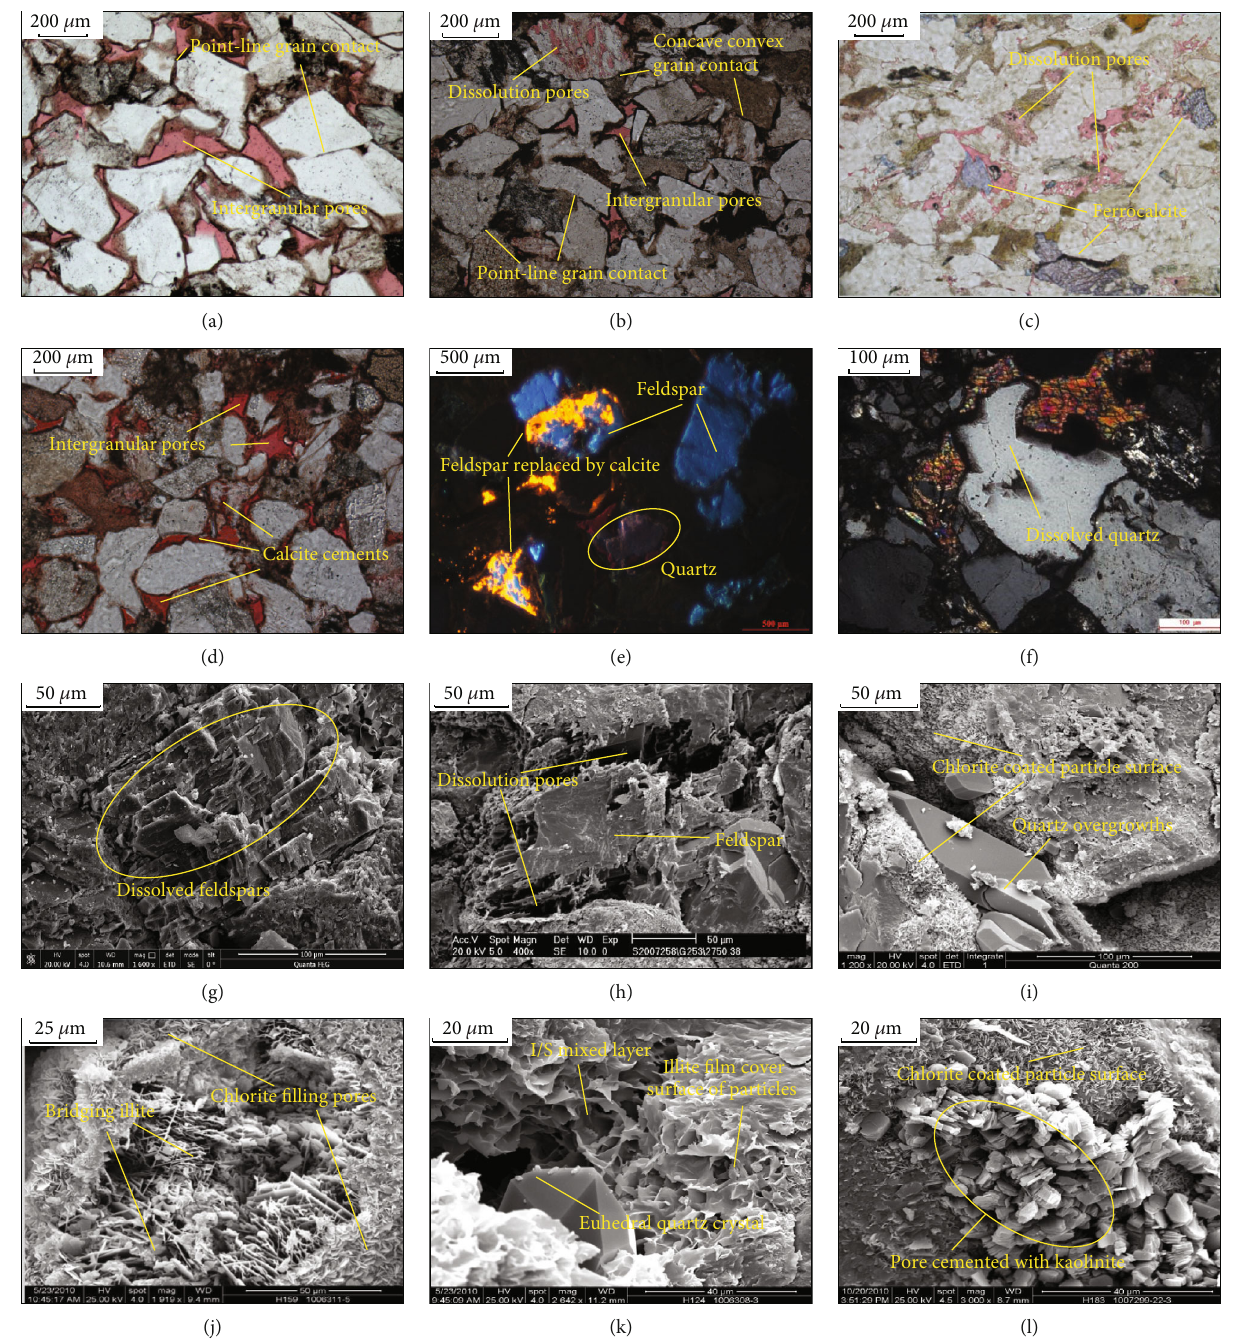
Figure 8: Comparison of di ff erent types of diagenesis between the YPA and APA Chang 8 reservoirs. Thin section photomicrographs, 2 cathodoluminescence, and SEM images showing (a) APA, point-line grain contact; (b) YPA, point-line grain contact and concave-convex contact; (c) APA, ferrocalcite metasomatic feldspar; (d) YPA, calcite metasomatic feldspar; (e) APA, feldspar dissolved and replaced by calcite; (f) YPA, quartz dissolution; (g) APA, feldspar dissolution; (h) YPA, dissolved feldspar and dissolution pores; (i) APA, siliceous cementation and quartz overgrowth; (j) APA, illite bridging cemented fi lling pores; (k) YPA, illite and I/S mixed layer, siliceous cementation fi lling intergranular pores; and (l) YPA, chlorite coating, chlorite, and kaolinite fi lling dissolved